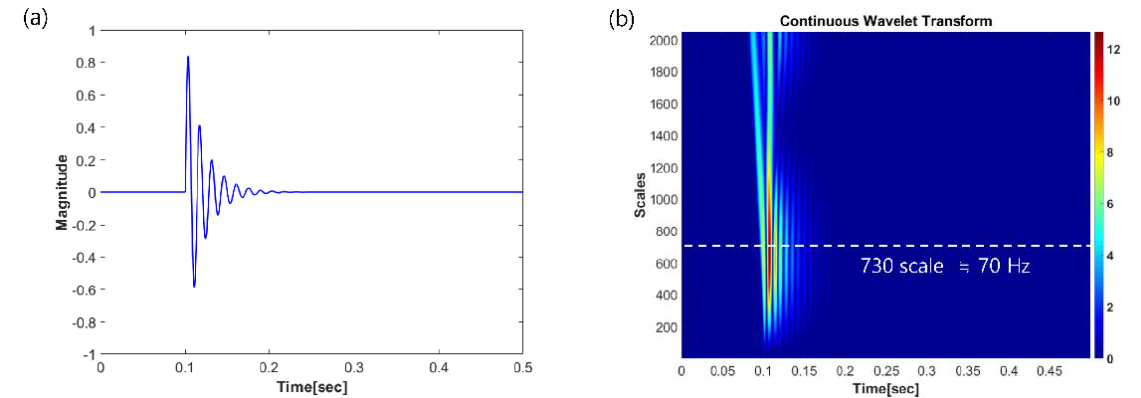
Figure 3. An impact signal ( a ) and its continuous wavelet transform (CWT) ( b ).